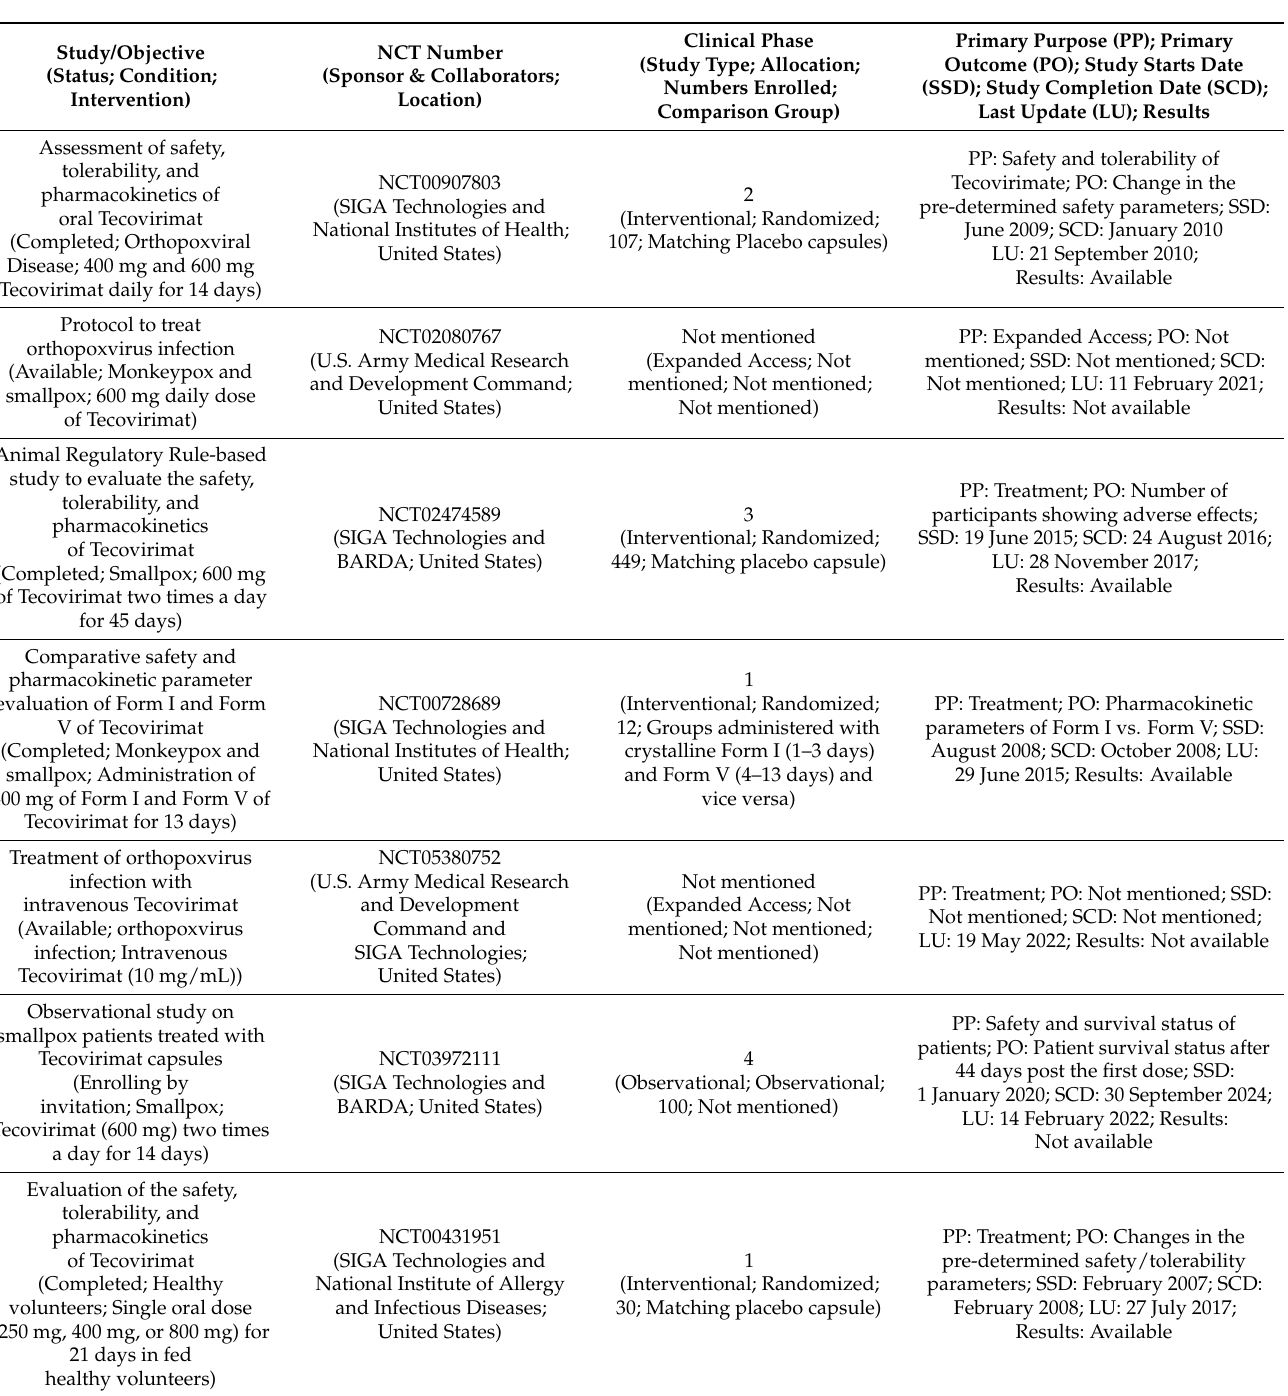
Table 3. Summary of the clinical studies of